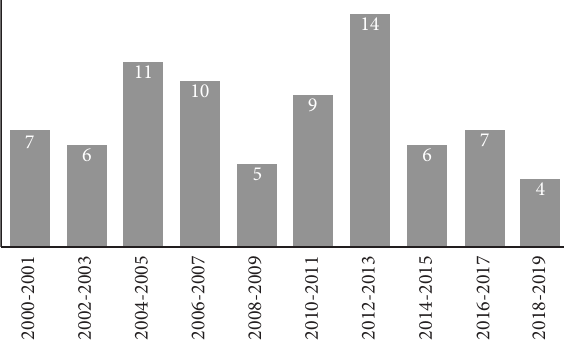
Figure 1: Incidence of Fusarium keratitis cases at two tertiary centers in South Korea during the period Table 2: Ocular predisposing factors for eyes with culture-proven Fusarium keratitis divided by the initial KOH smear. Predisposing factors ∗